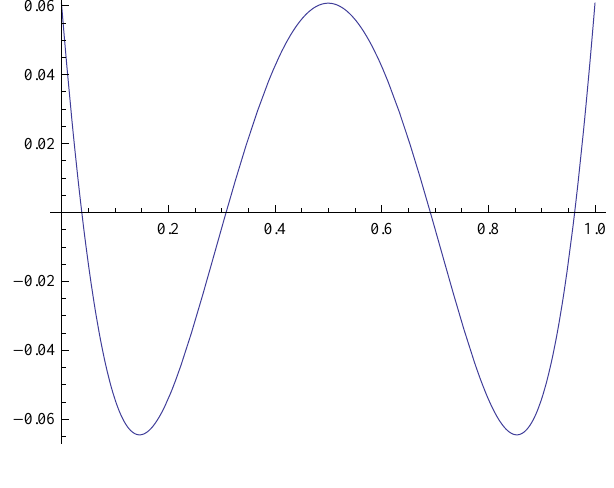
Fig. 4. Euclidean error of the quadratic approximating Bézier